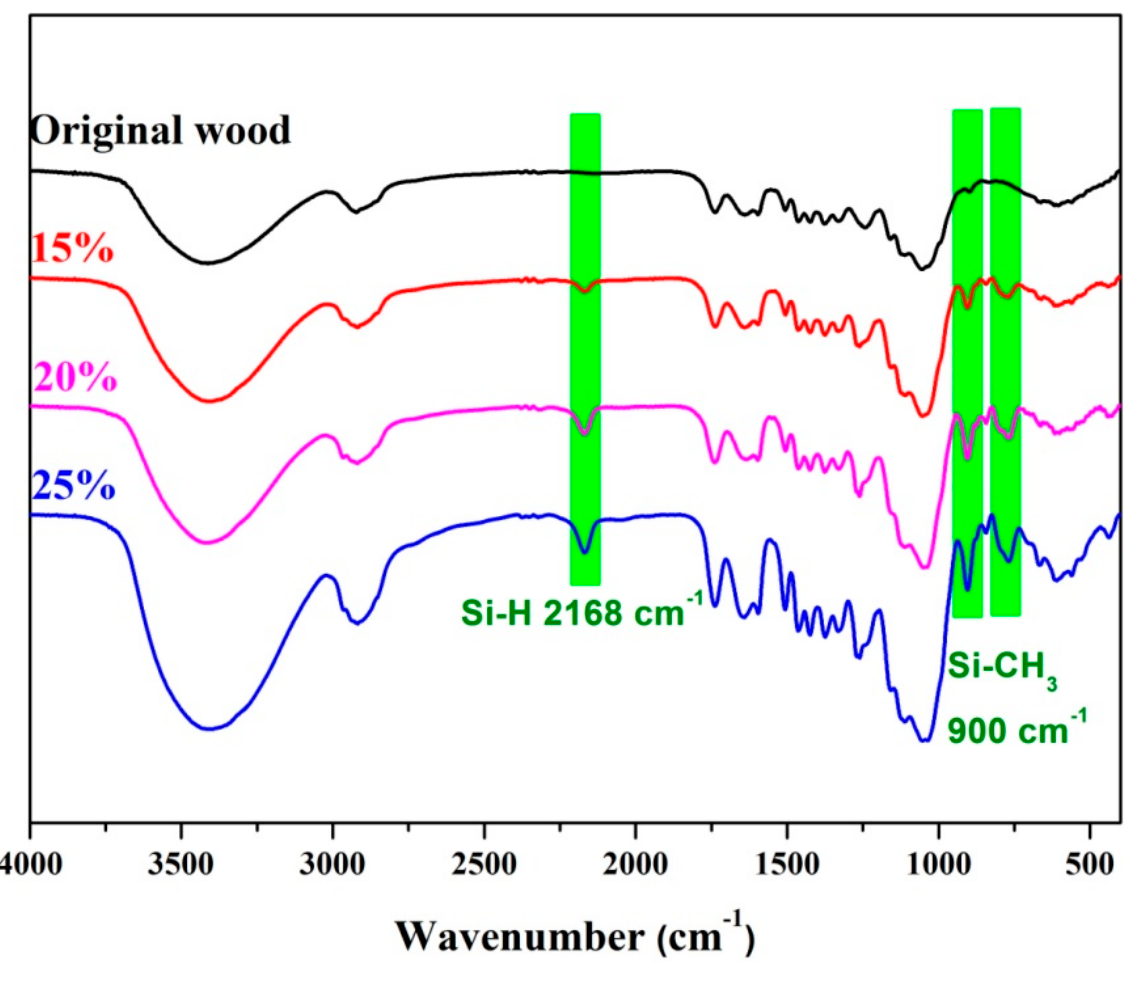
Figure 2. FTIR spectra of wood before and after D4H modification